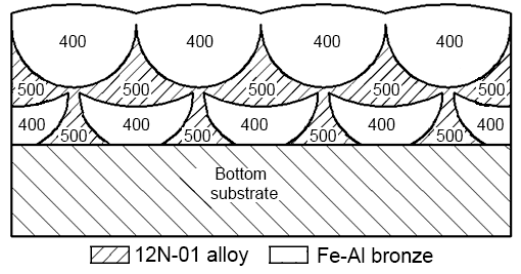
Figure 19. The scheme of microhardness changes in a double composite layer.